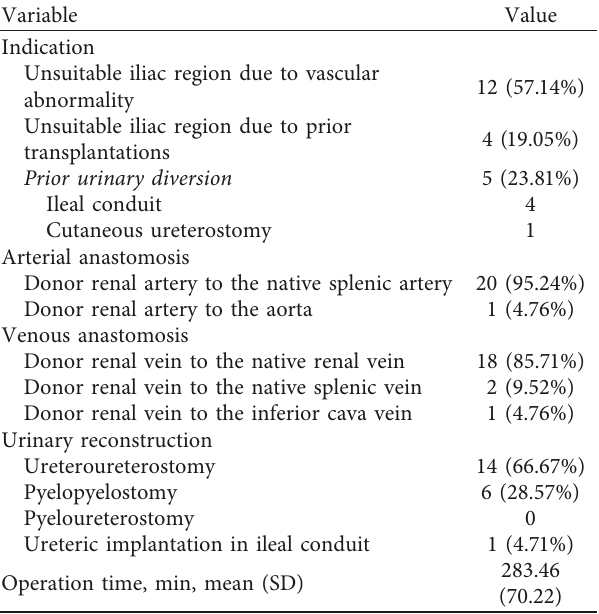
Table 3: Indications of OKTs and surgical